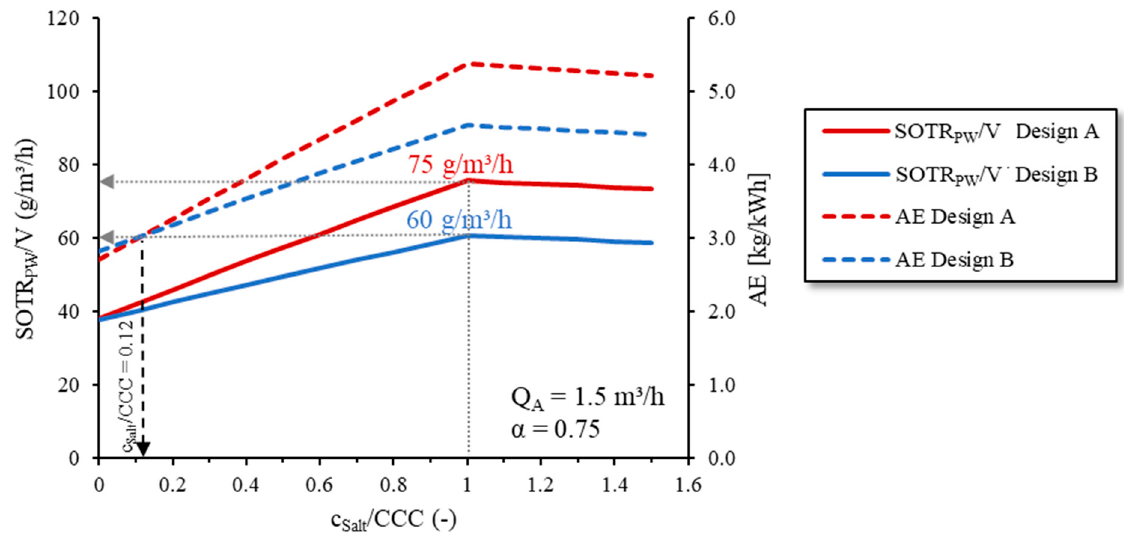
Figure 10. SOTR PW in activated sludge ( α = 0.75) per aerated water volume V ( SOTR PW / V ) and AE for both diffuser membrane designs as a function of c Salt / CCC at a fixed airflow rate of 1.5 m 3 /h.